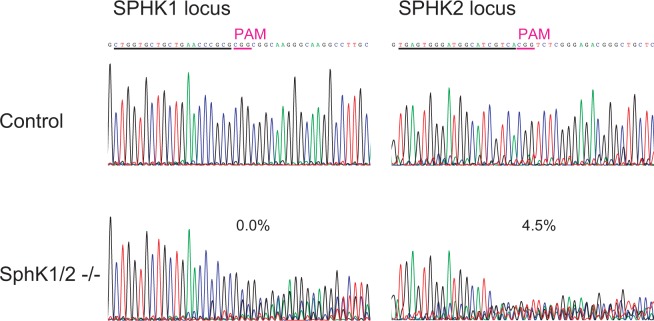
Analysis of mutation rates in knockout cells.Each target locus was analyzed by PCR direct sequencing. High rates of aberrant sequences are observed around the estimated cutting site, at 3 bp from the NGG protospacer adjacent motifs (PAMs), only in the intended mutant cells. Guide RNA target sequences are underlined. The indicated values are the percentage of signals equivalent to control samples that were calculated by TIDE (tracking of indels by decomposition) analysis.